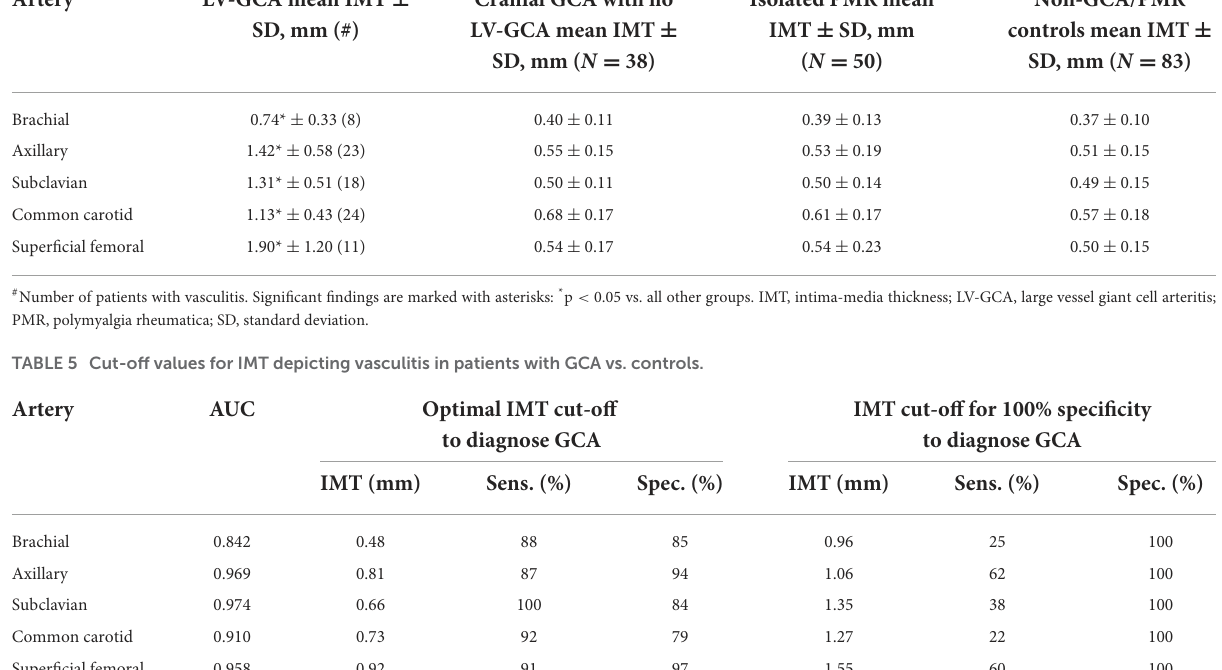
TABLE 4 Mean IMT in different affected large arteries in LV-GCA vs. cranial GCA with no LV-GCA, isolated PMR, and controls. Artery